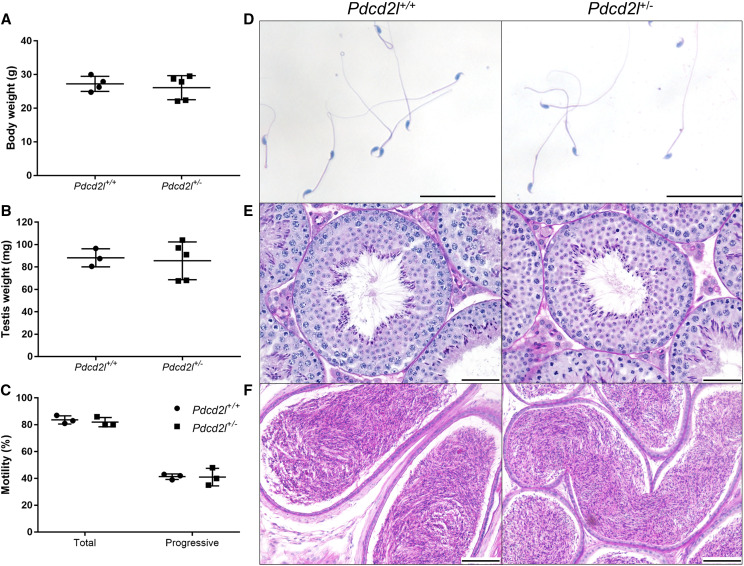
Fertility examination of heterozygous Pdcd2l male mice in comparison to wildtype males. Routine analyses were performed, comparing the following across genotypes: (A) body weight, (B) testis weight, (C) sperm motility analysis, (D) sperm morphology, (E) testis histology and (F) epididymal histology.